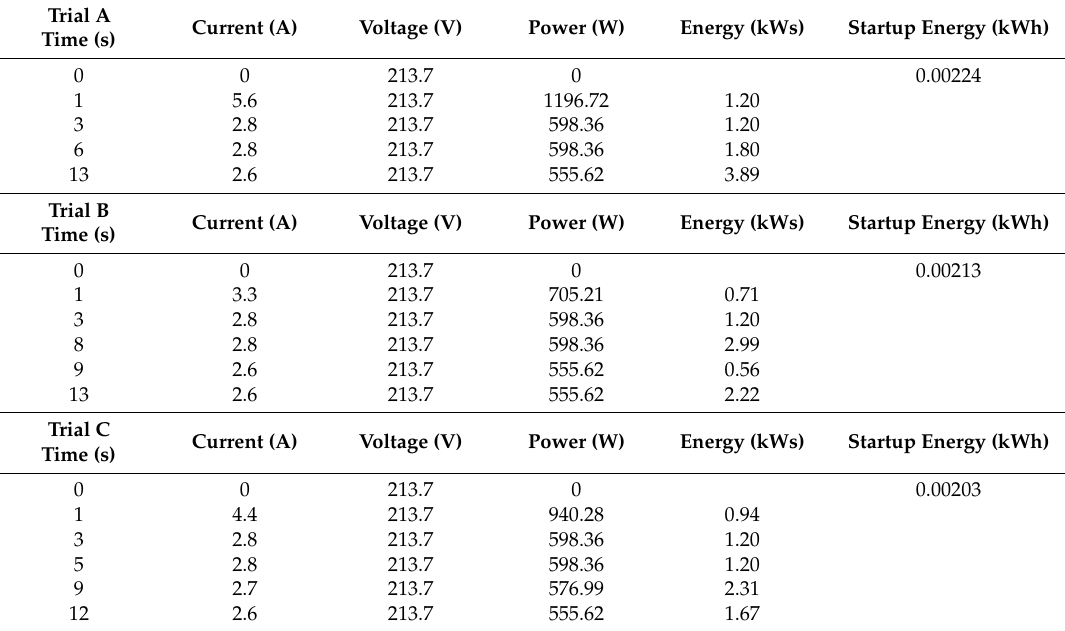
Table A2. Grundfos Pump Startup Energy, Collected